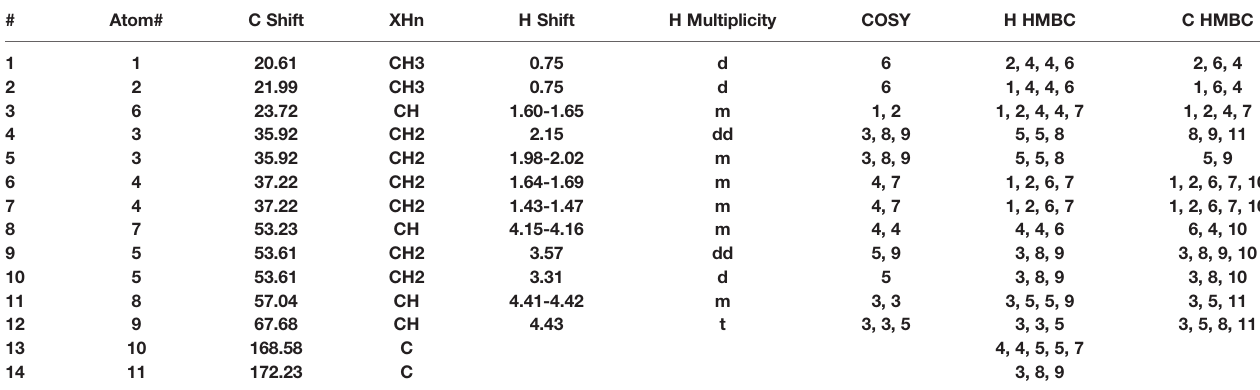
TABLE 2 | Chemical shifts and 2D correlations of NMR spectra in H8-2.